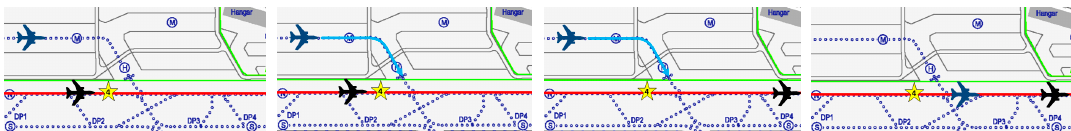
Figure 2. Example of an animated sequence of a traffic situation as it was used in the gaming workshop (Black aircraft = RPAS, red line = segmented standard taxi route, yellow star = mandatory stop point for RPAS, blue aircraft = manned aircraft, light blue line = current taxi clearance of the manned aircraft). Aerodrome map provided by courtesy of DFS Deutsche Flugsicherung GmbH—not suited for navigational purposes.